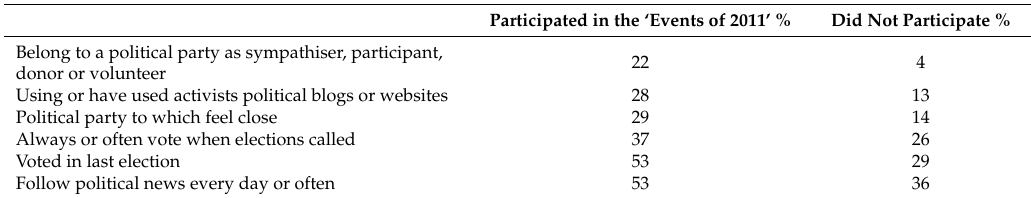
Table 1. Political participation, 20–29 year olds in 2015–2016. Participated in the ‘Events of 2011’ % Did Not Participate